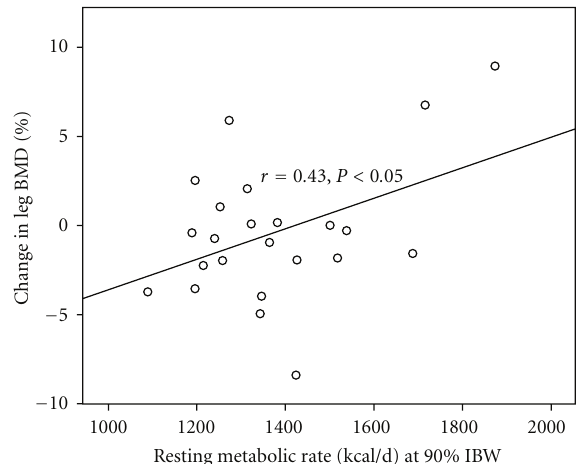
Figure 1: Correlation between resting metabolic rate of patients at 90%IBW and % change in spine BMD. Each circle represents the data point of a patient.